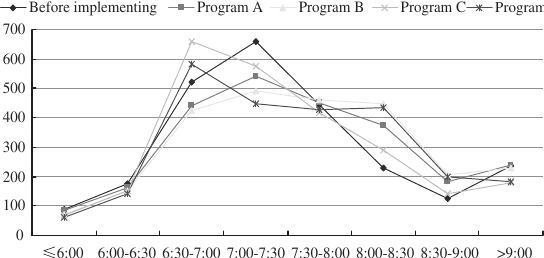
Table 8. The results indicate that when job starting